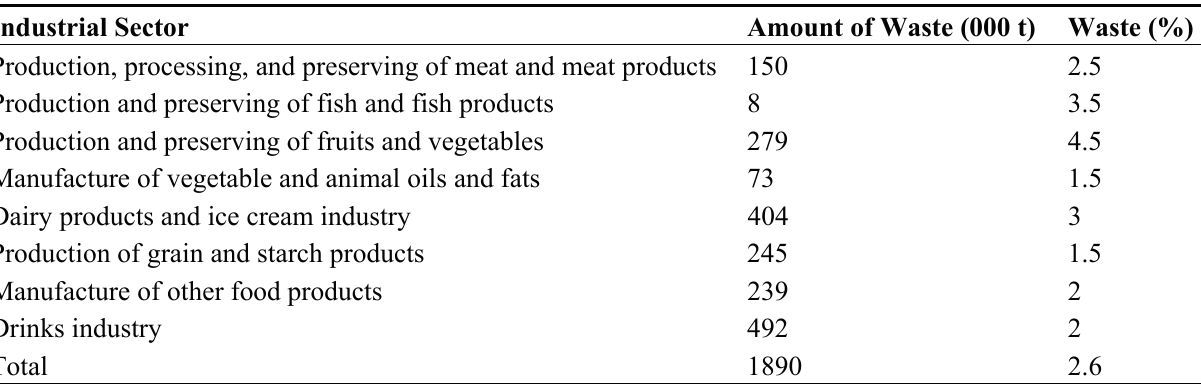
Table 1. Estimate of waste in the food industry